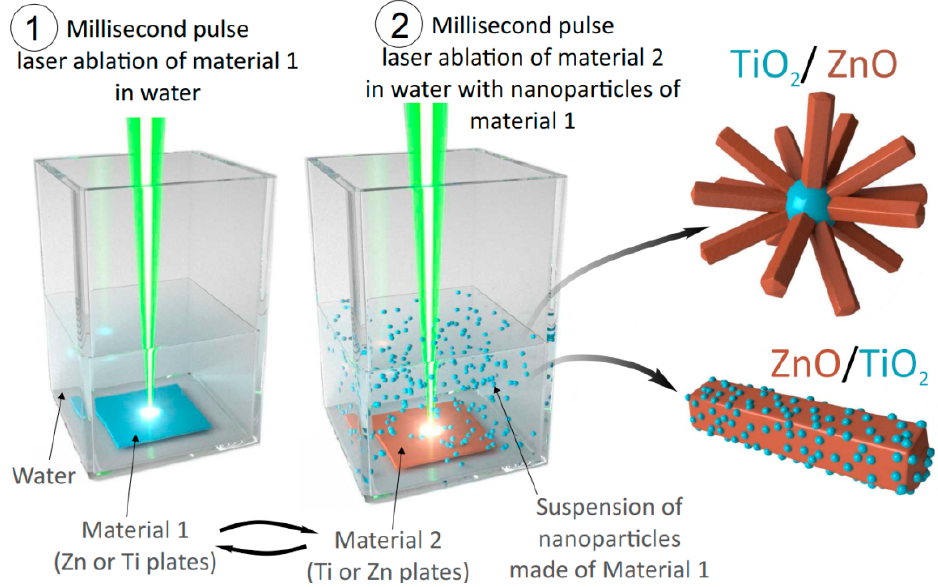
Figure 1. Schematic illustration of preparation procedure of hybrid nanomaterials ZnO/TiO 2 and TiO 2 /ZnO using PLAL.